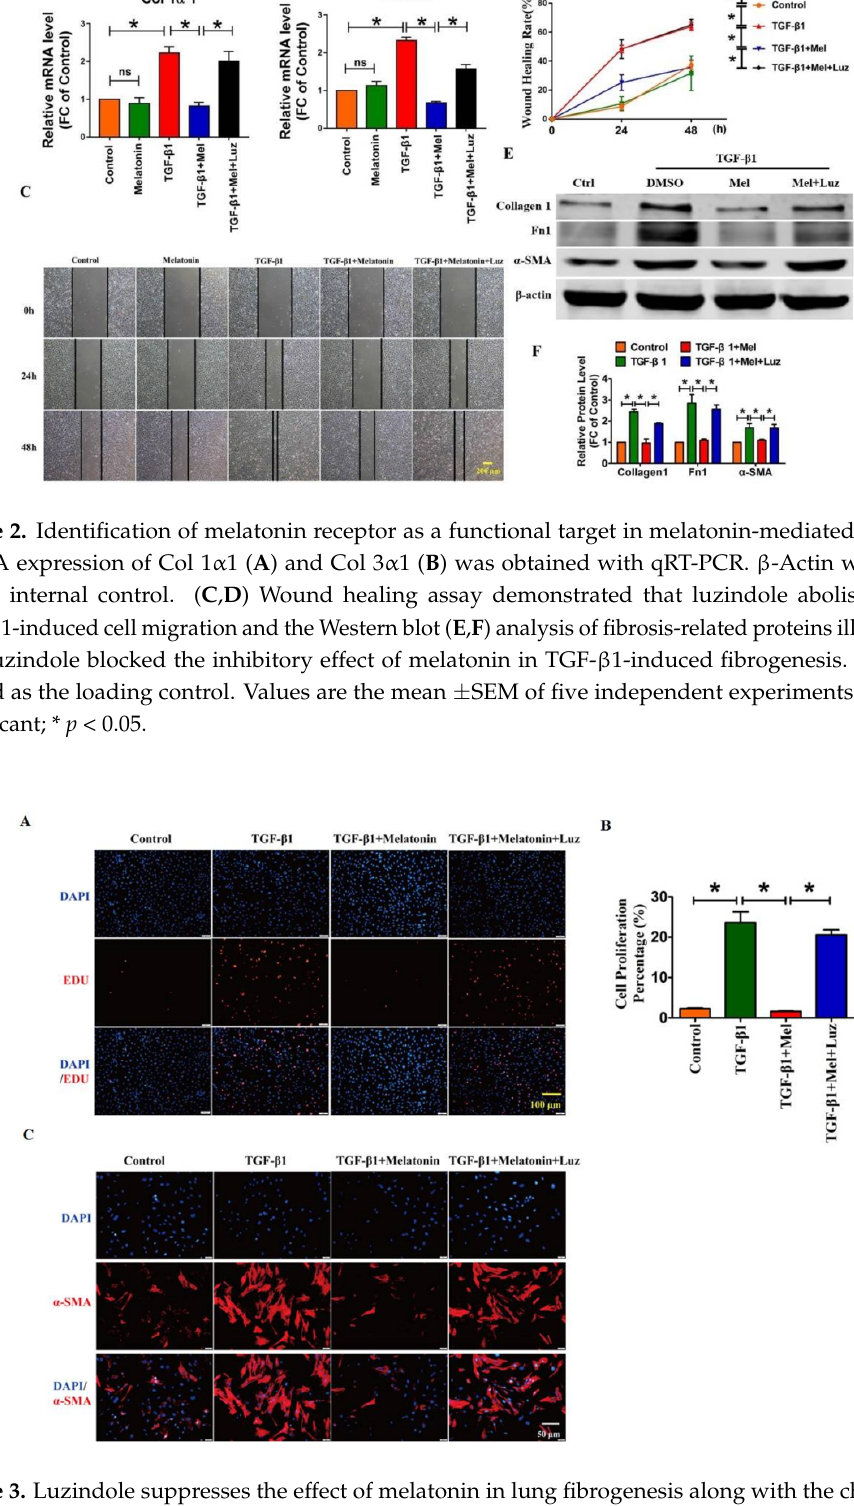
Figure 3. Luzindole suppresses the effect of melatonin in lung fibrogenesis along with the change of cell proliferation and myofibroblasts activation. ( A ) The analysis of EDU staining demonstrated the cell proliferation ability of lung fibroblasts with different treatments; ( B ) The statistical diagram of the EDU assay; ( C ) Immunostaining of α -SMA in lung fibroblasts demonstrated the inhibitory effect of luzindole. Values are the mean ± SEM of five independent experiments. * p <